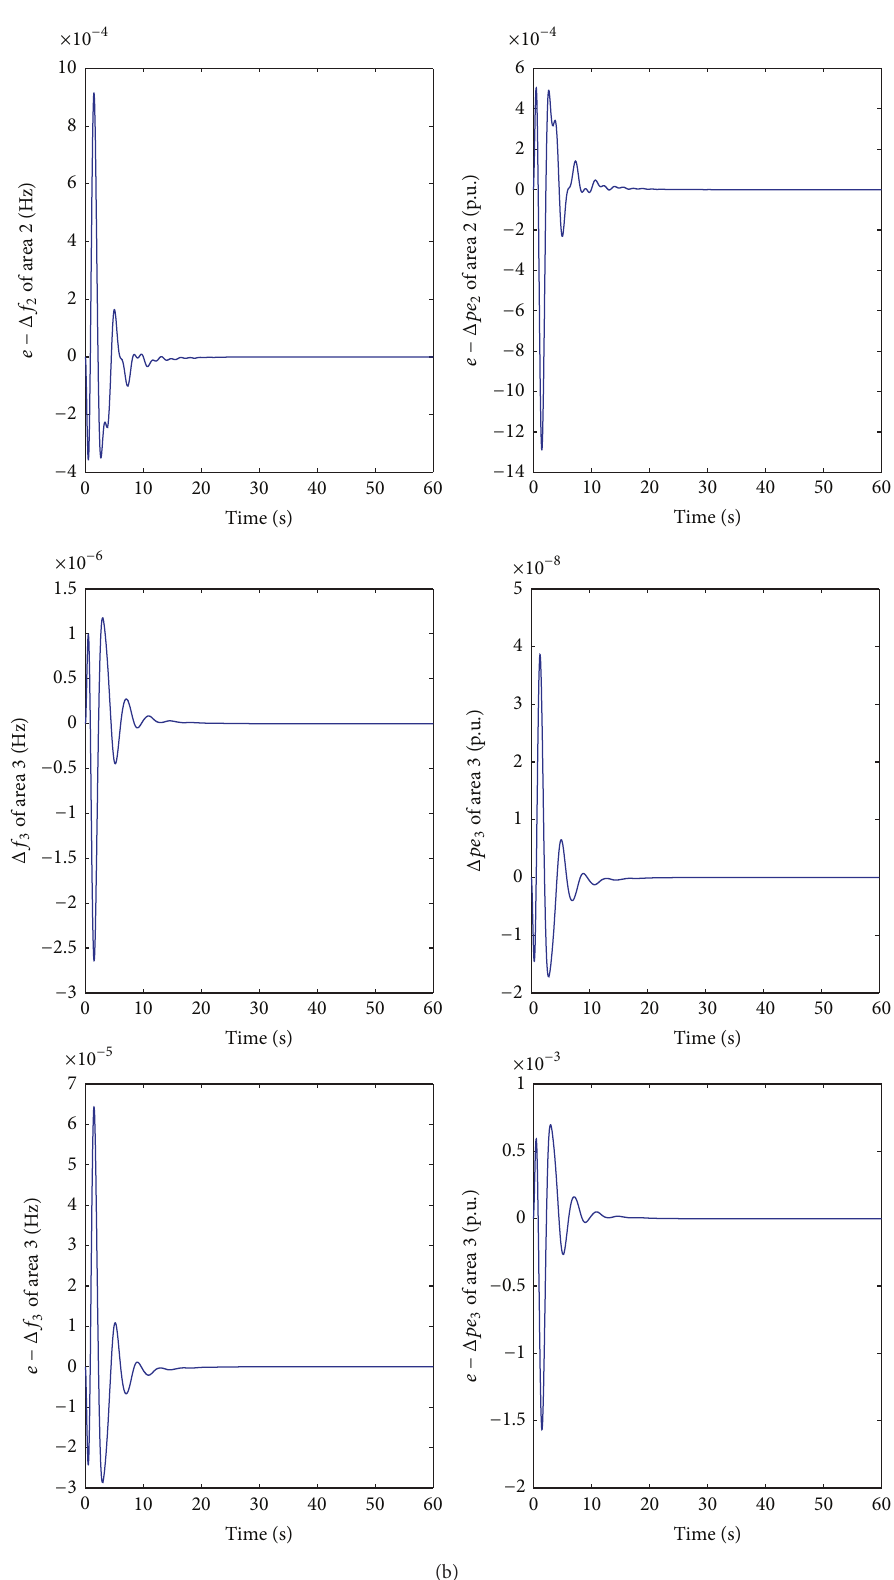
Figure 9: Step load disturbance responses and observation errors of the original subsystems and the newly added